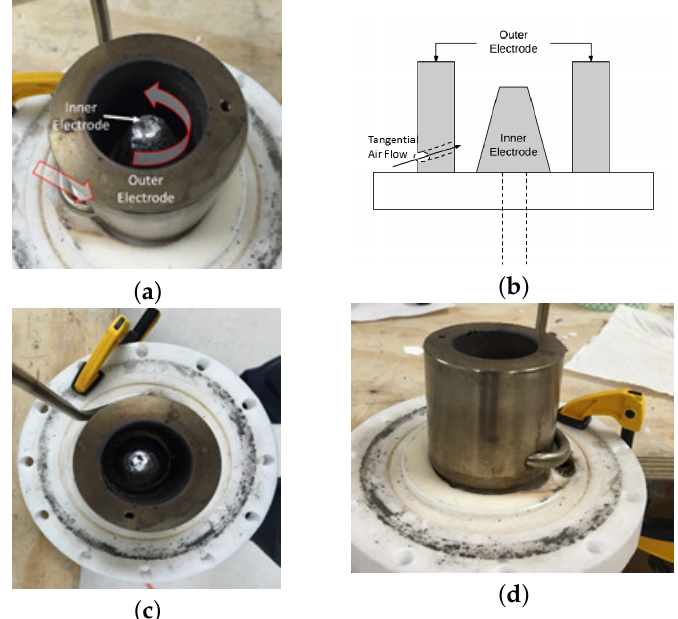
Figure 1. ( a ) Geometry of 3D-GAVR prototype; ( b ) CSA of 3D-GAVR; ( c ) top view 3D-GAVR; and ( d ) side view 3D-GAVR.